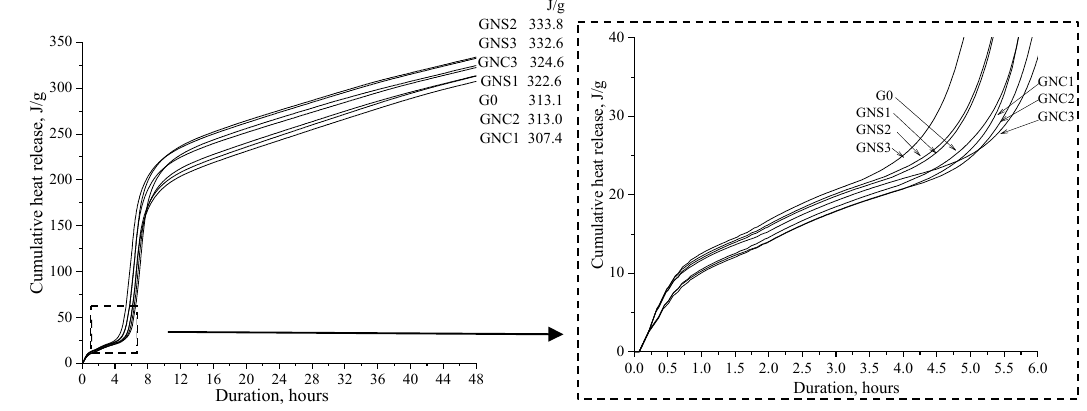
Figure 3. Cumulative heat release of cement pastes with NS and NC.